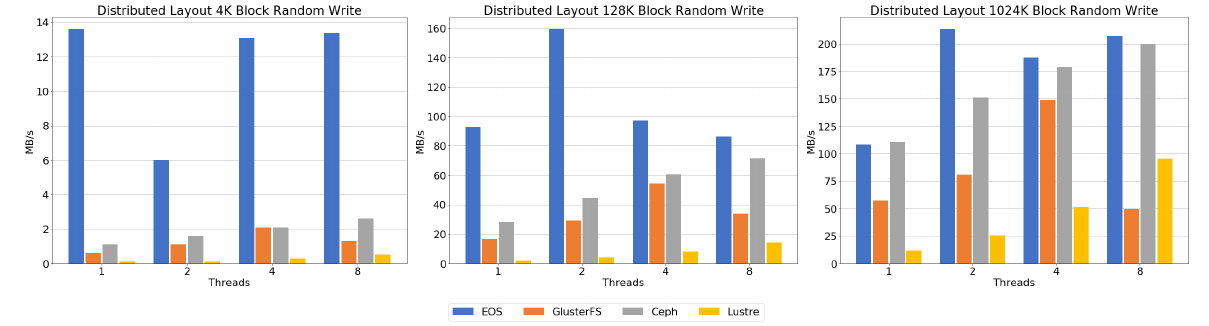
Figure 13. Distributed layout—random write